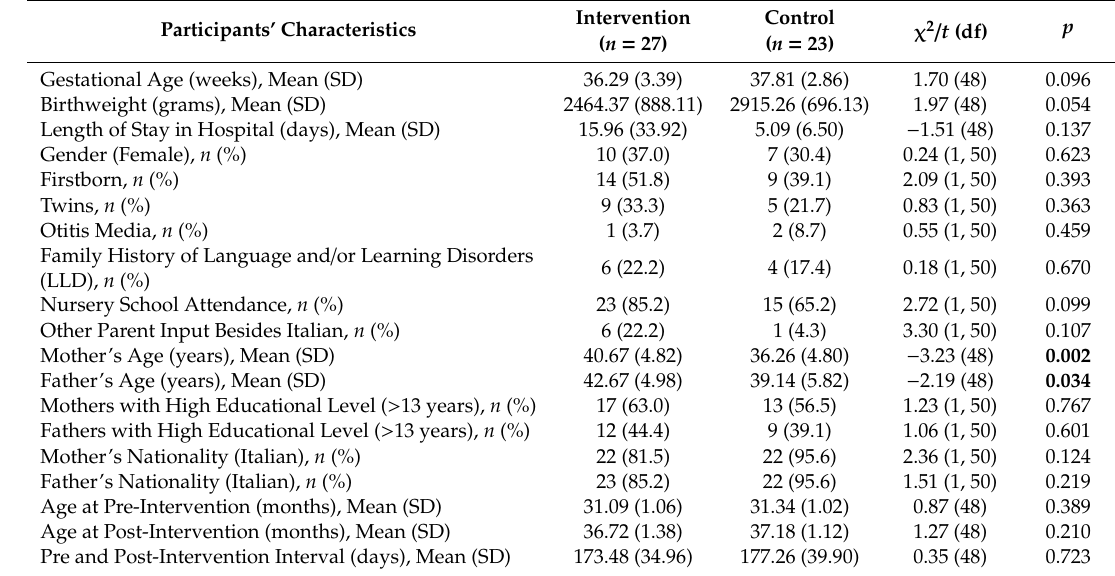
Table 1. Sociodemographic characteristics of participants in the entire